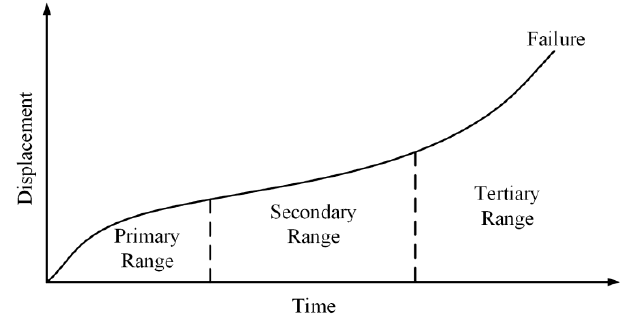
Figure 1. Strain as a function of time for the three creep stages [3].